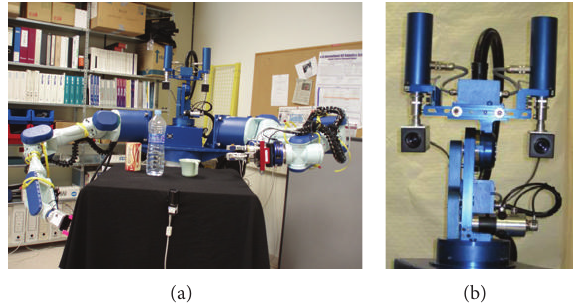
Figure 12: Experimental setup: external view of the used humanoid robot (a) and a detailed view of the pan/tilt/vergence head (b).